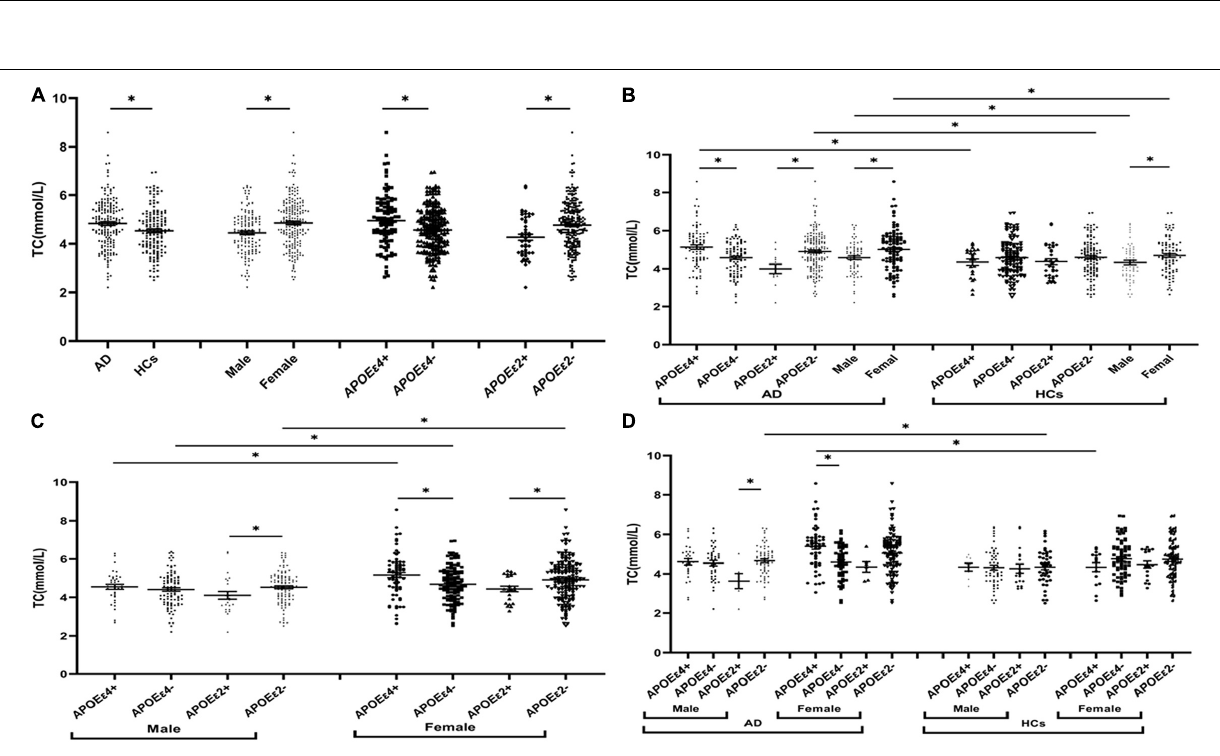
Frontiers in Aging Neuroscience |